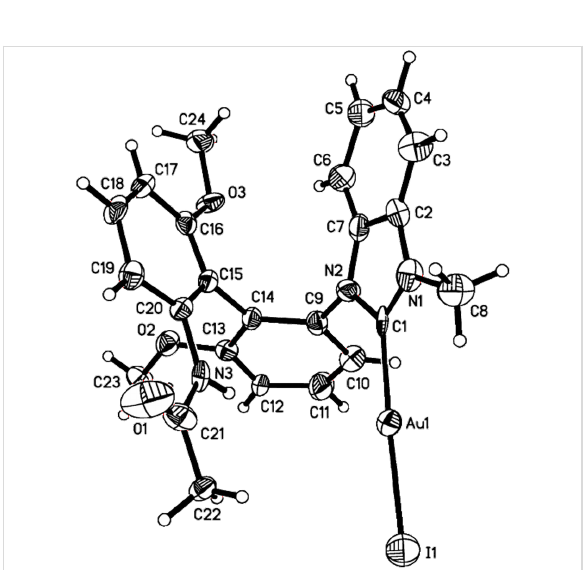
Figure 4: ORTEP drawing of NHC–Au(I) complex ( S )- 6a with thermal ellipsoids at the 30% probability level. Selected bond distances (Å) and angles (deg): Au1–C1 = 2.036(14), Au1–I1 = 2.5093(13), C1–Au1–I1 = 176.5(3), N1–C1–Au1 = 125.7(9), N2–C1–Au =